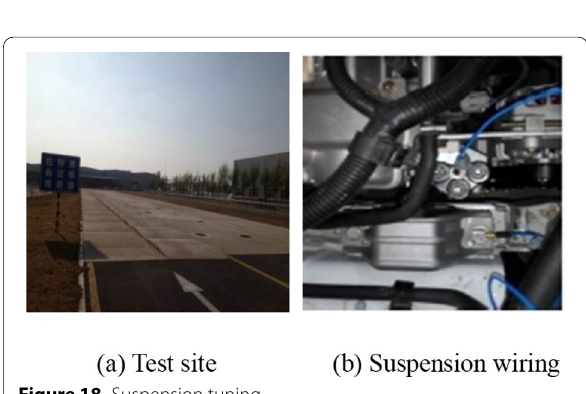
Figure 18 Suspension